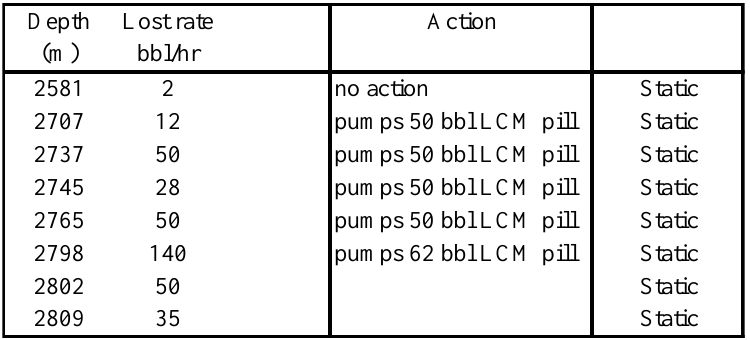
Table A.2 Mud loss data for Machar Field (SPE 36832,